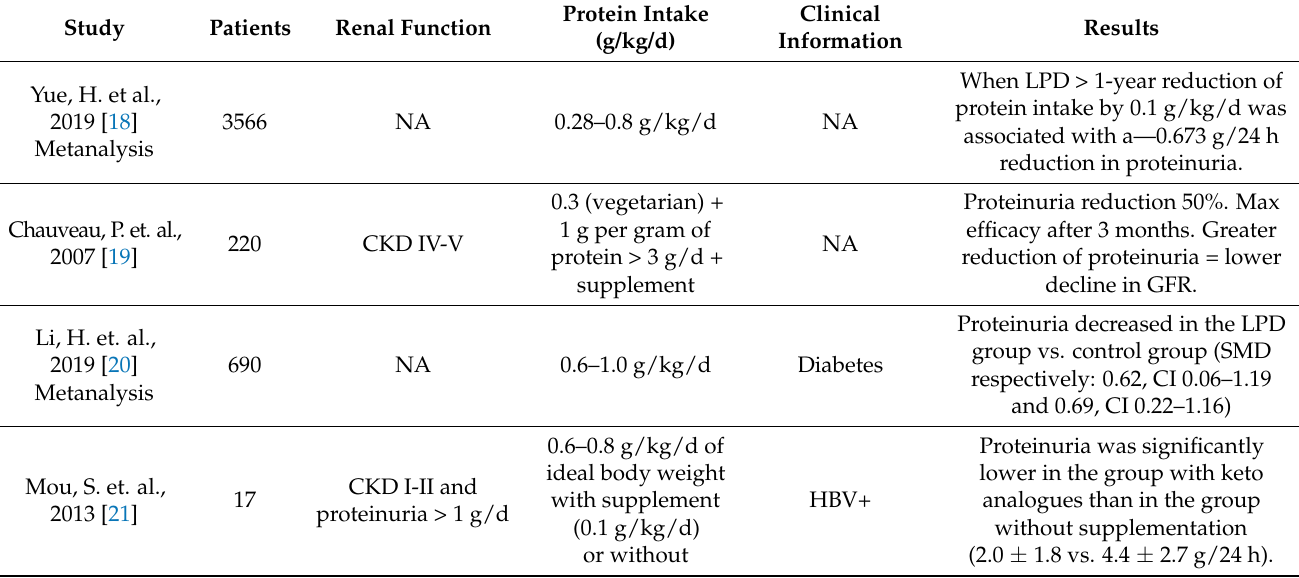
Table 1. Principal clinical studies of protein intake in